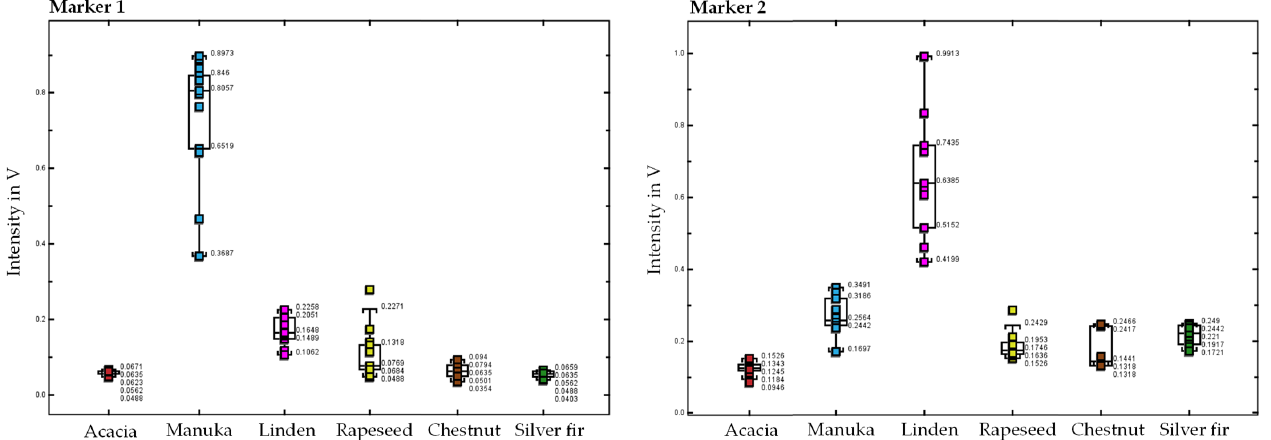
Figure 3. Box plots for two exemplary marker compounds (left marker 1 and right marker 2), with the intensity on the y-axis and the samples grouped by honey type on the x-axis (acacia, manuka, linden, rapeseed, chestnut, and silver